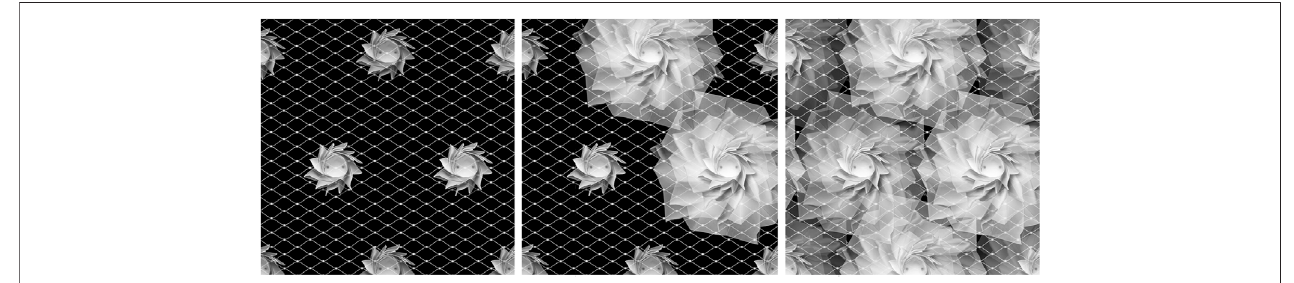
FIGURE3| PAOSSsun-shadingsystem.Inclosedstate(left),inpartiallyactuatedstateasselectiveglareprotection(middle)andinopenstateasfullsunprotection (right) (source: ILEK/(Eisenbarth et al., 2021)).